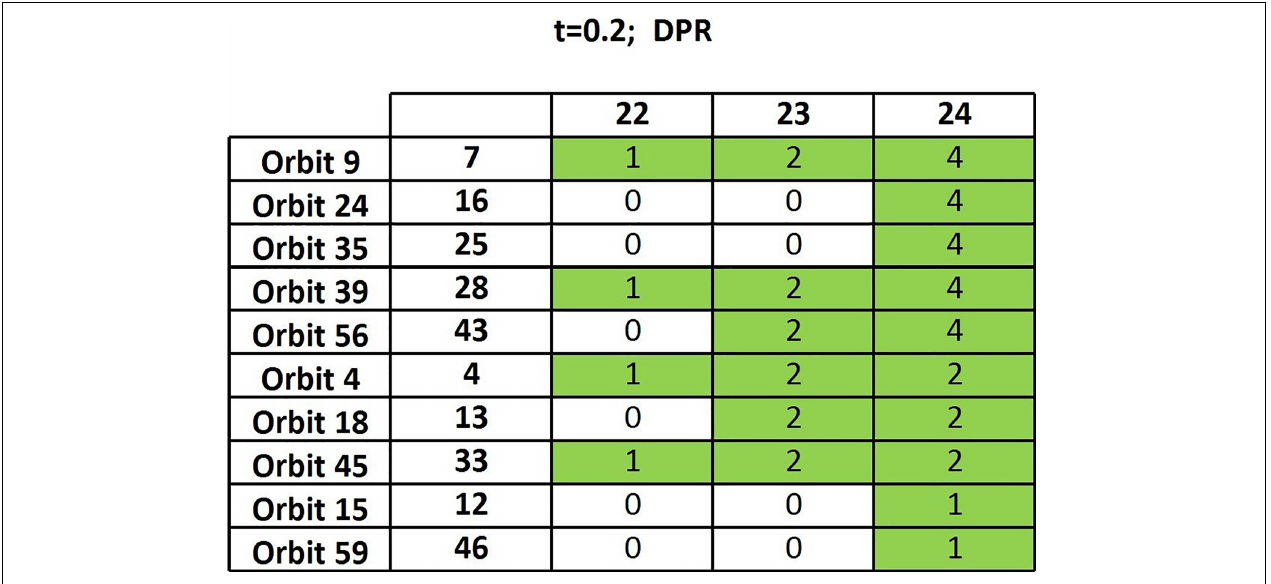
FIGURE 3 | Output table of the algorithm of section “Frequency Table and Node Table” when randomized matrices are